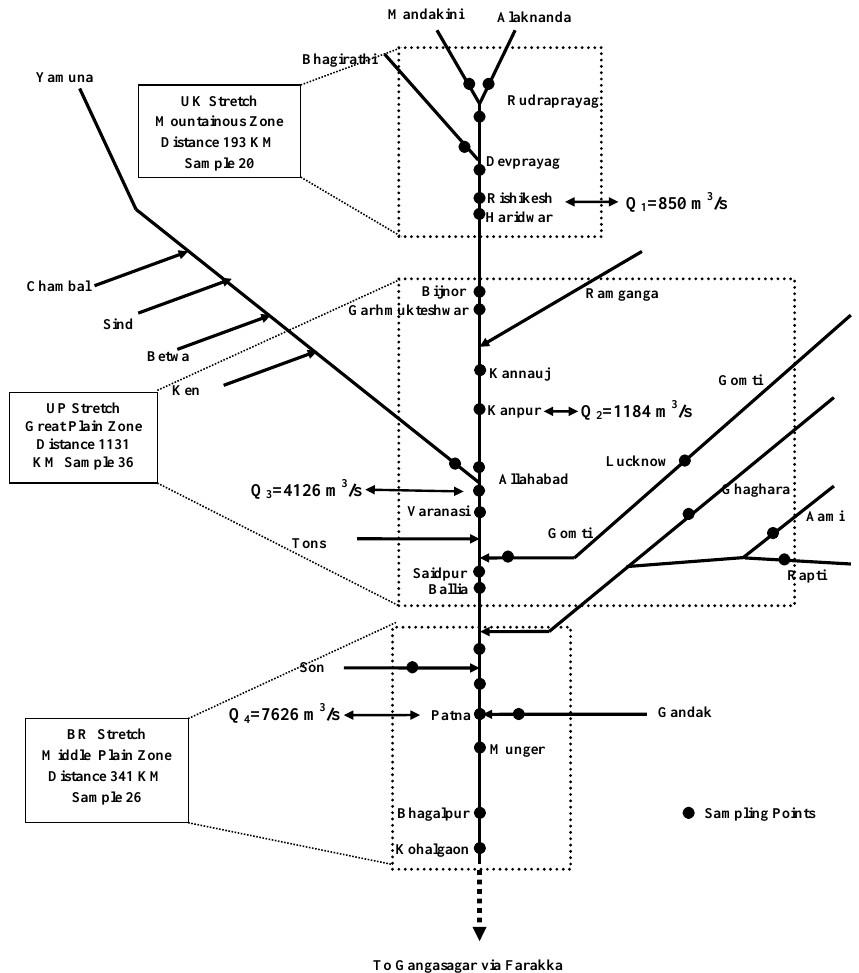
Figure 2. Sampling locations and space boundary of each sampling campaign along river Ganga (flow data were of CWC, Delhi taken from NGBRA, 2011 report as cross reference)